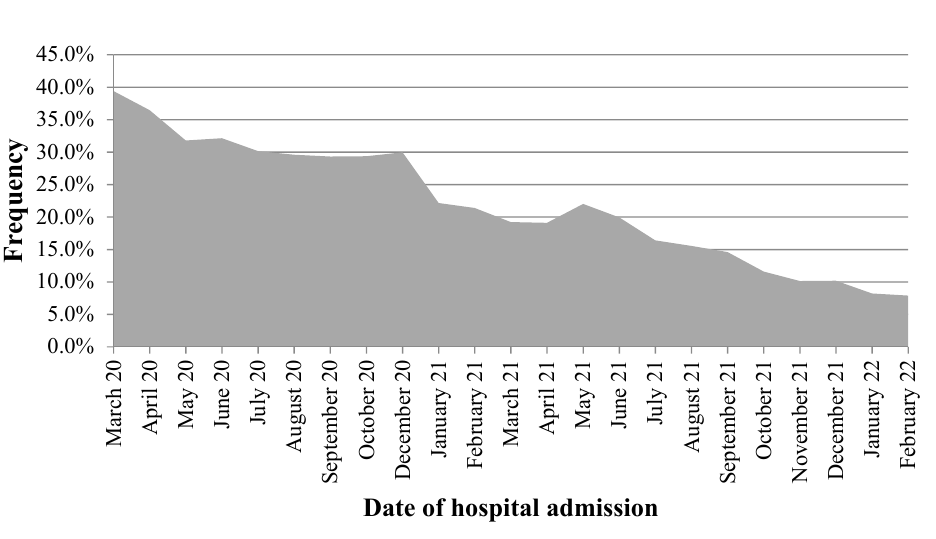
Figure 1. Frequency of empirical antibiotic prescription in inpatients with laboratory-confirmed